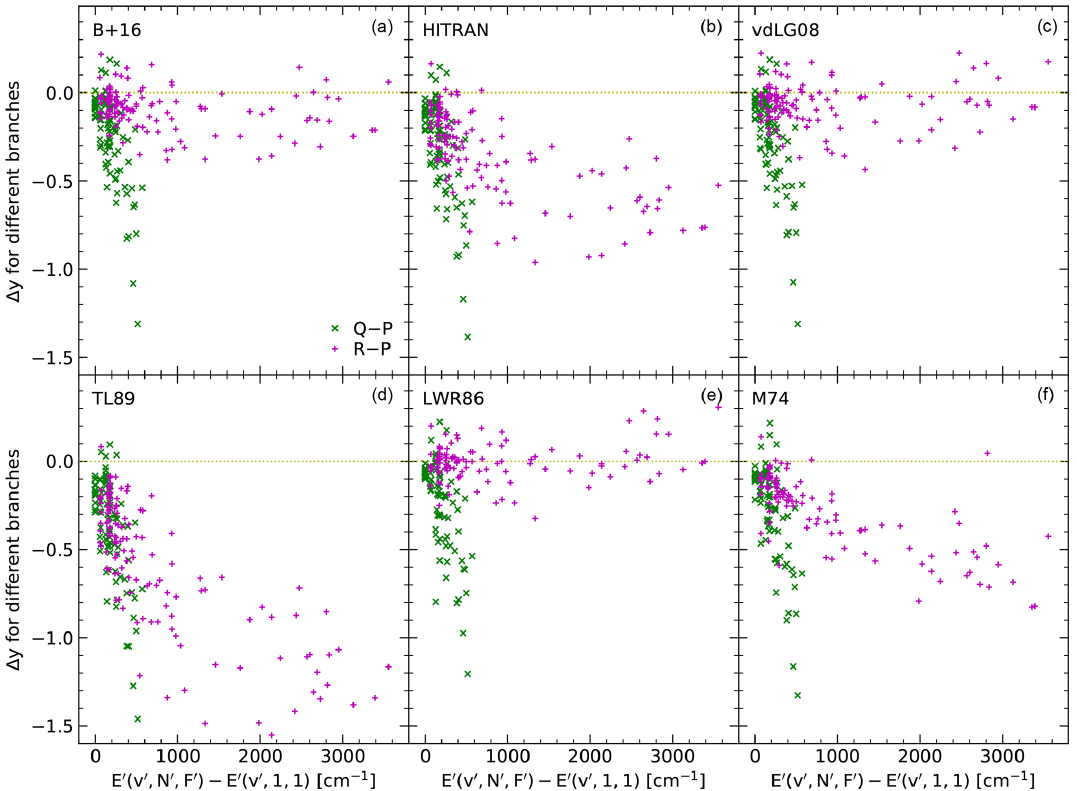
Figure 6. Difference in logarithmic OH level populations (cid:49)y by the change of the branch of the measured transitions from P to Q or R as a function of the upper-state energy E (cid:48) relative to the v (cid:48) -specific zero point (corresponding to N (cid:48) = 1 and F (cid:48) = 1) in inverse centimetres for six sets of Einstein- A coefficients. For more details, see the legend and Fig.